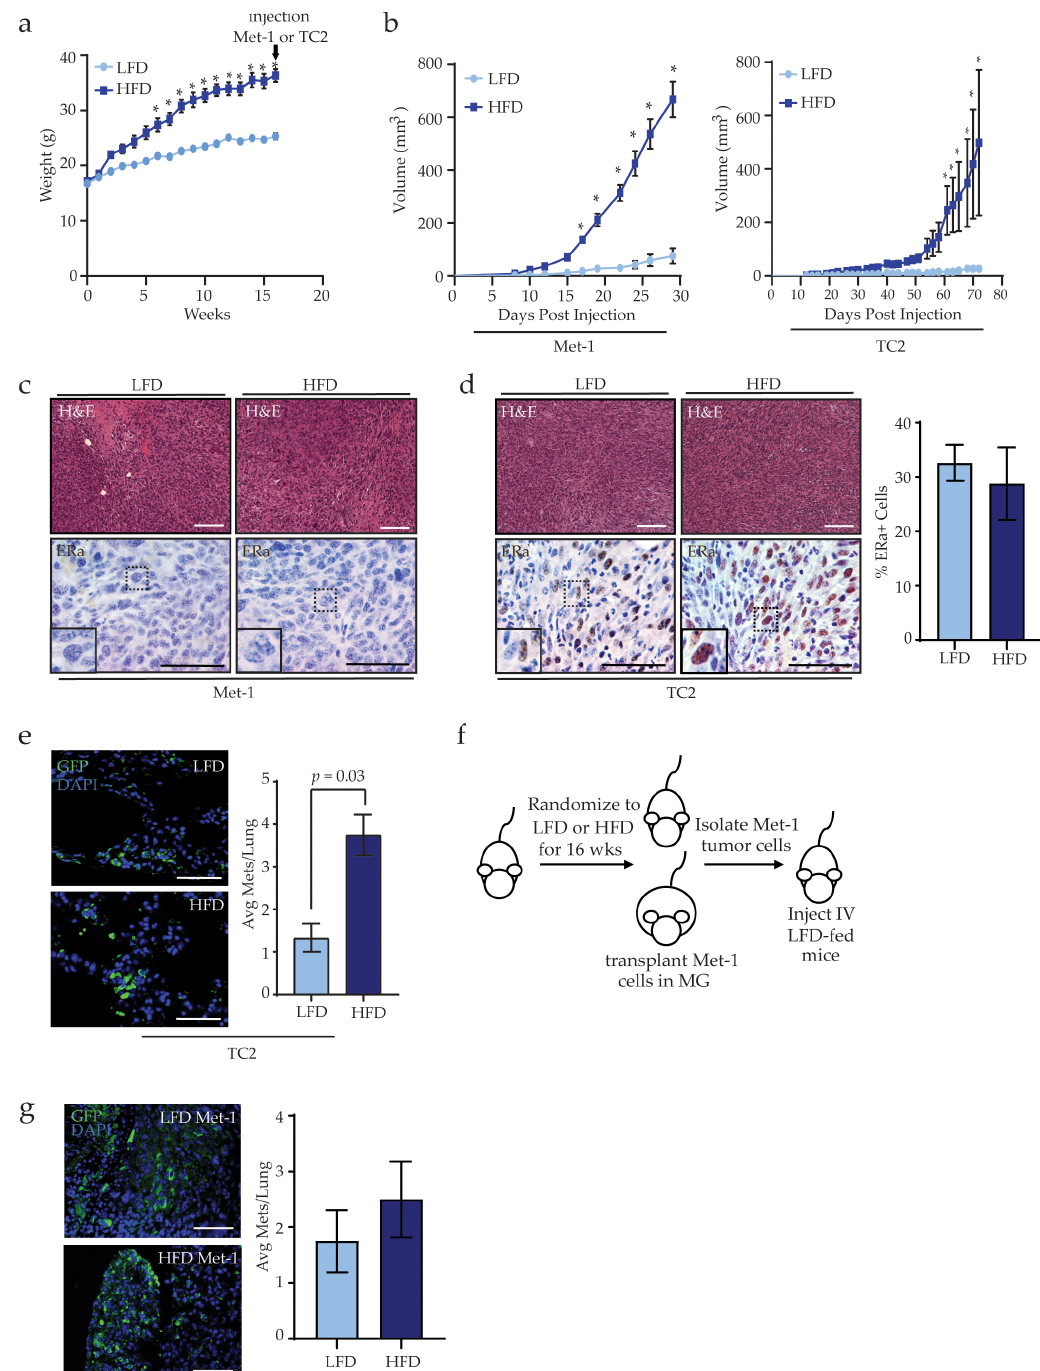
Figure 1. Obesity increases breast cancer metastasis. ( a ) Weight gain of female mice fed either the low-fat diet (LFD) or high-fat diet (HFD) for 16 weeks prior to tumor cell transplantation (arrow; n = 8 mice/group, * p < 0.05). ( b ) Growth curves of Met-1 or TC2 tumor cells transplanted into mammary glands of LFD- or HFD-fed female mice (n = 4 mice/group, * p < 0.05). ( c ) Representative images of Met-1 tumors stained with hematoxylin and eosin (H&E) or immunohistochemistry (IHC) to detect estrogen receptor alpha (ER α ). ( d ) Representative images of TC2 tumors stained with H&E or IHC for ER α . Quantification of ER α + cells in tumors from LFD- or HFD-fed mice (n = 4 mice/group). ( e ) Quantification of metastatic foci of green fluorescent protein (GFP)-expressing TC2 tumor cells in lungs of LFD- and HFD-fed mice (n = 4 mice/group). ( f ) Schematic of experiment to inject tumor cells into the tail vein of LFD-fed mice. ( g ) Quantification of Met-1 metastatic foci in lungs of LFD-fed mice (n = 5 mice/group). Magnification bars = 50 µ